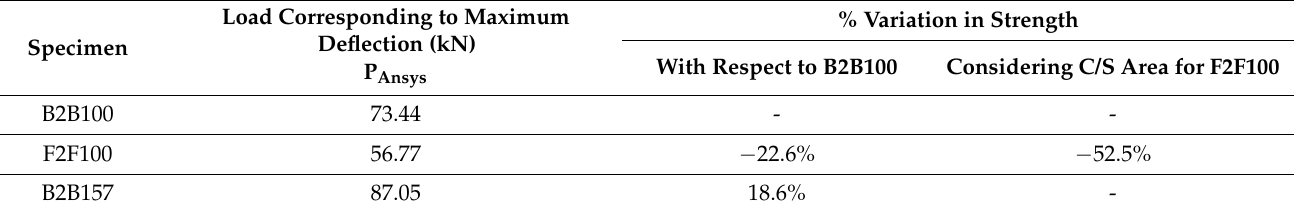
Figure 5. Buckling and stress distribution of B2B157.